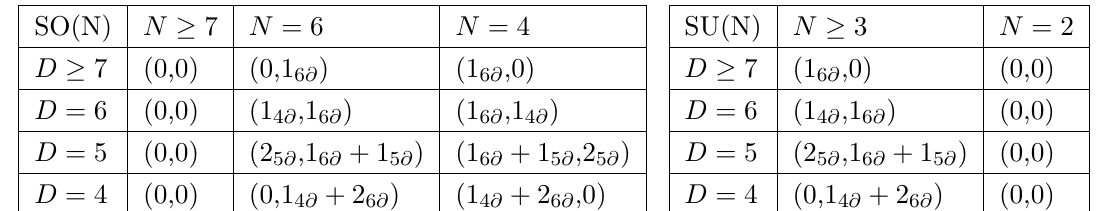
Table 12 . The number of generators ( n 3 , n 3 the derivative